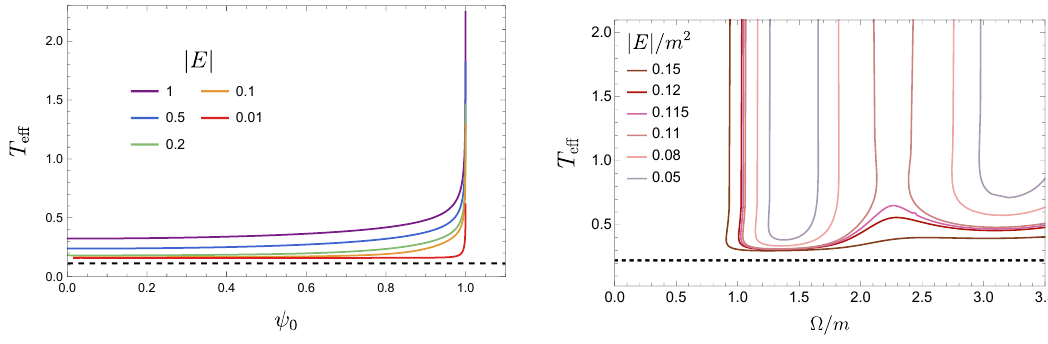
Figure 2 . Left plot : effective temperature for different BH embeddings labelled by the insertion angle at the effective horizon ψ 0 = ψ ( u c ) . Right plot : effective temperature as we vary Ω /m at fixed | E | /m 2 . In both cases, the divergence in T eff arises as the curves come close to the critical embeddings. In both plots, the lowest dashed line in black signals the background